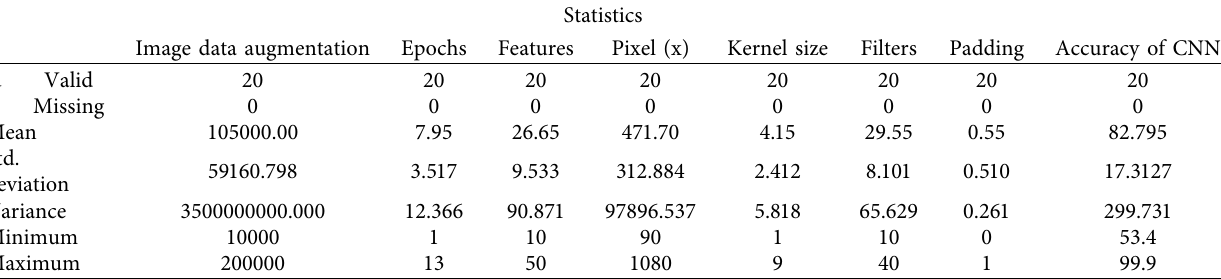
Figure 5: Research flowchart. Table 1: Descriptive statistics’ output showing minimum, maximum, mean, and other values.